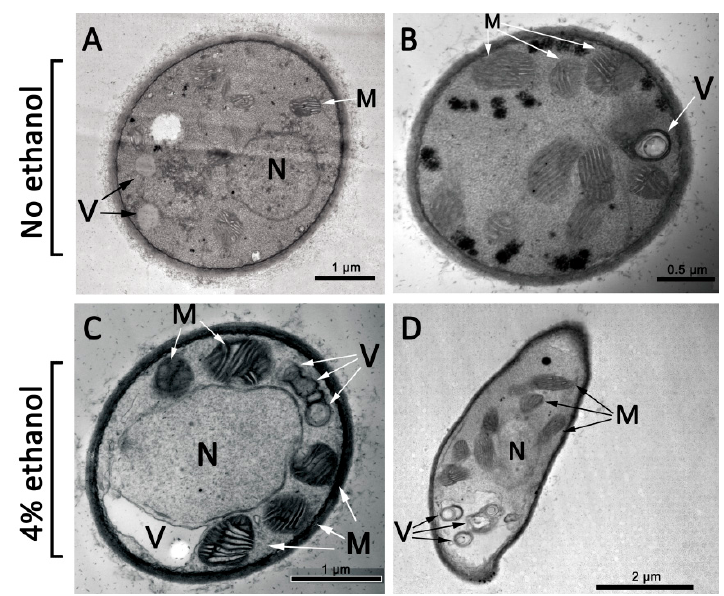
Figure 3. Transmission electron microscopy analysis of the adaptive response of A. oryzae to ethanol stress. Under conditions of 4% ethanol treatment, the segregated vacuoles became increasingly aggregated, and the cellular nuclei appeared swollen and lengthened. ( A,B ) A. oryzae cells without ethanol. ( C,D ) A. oryzae cells under 4% ethanol. M: mitochondria; N: nucleus; V: vacuole.